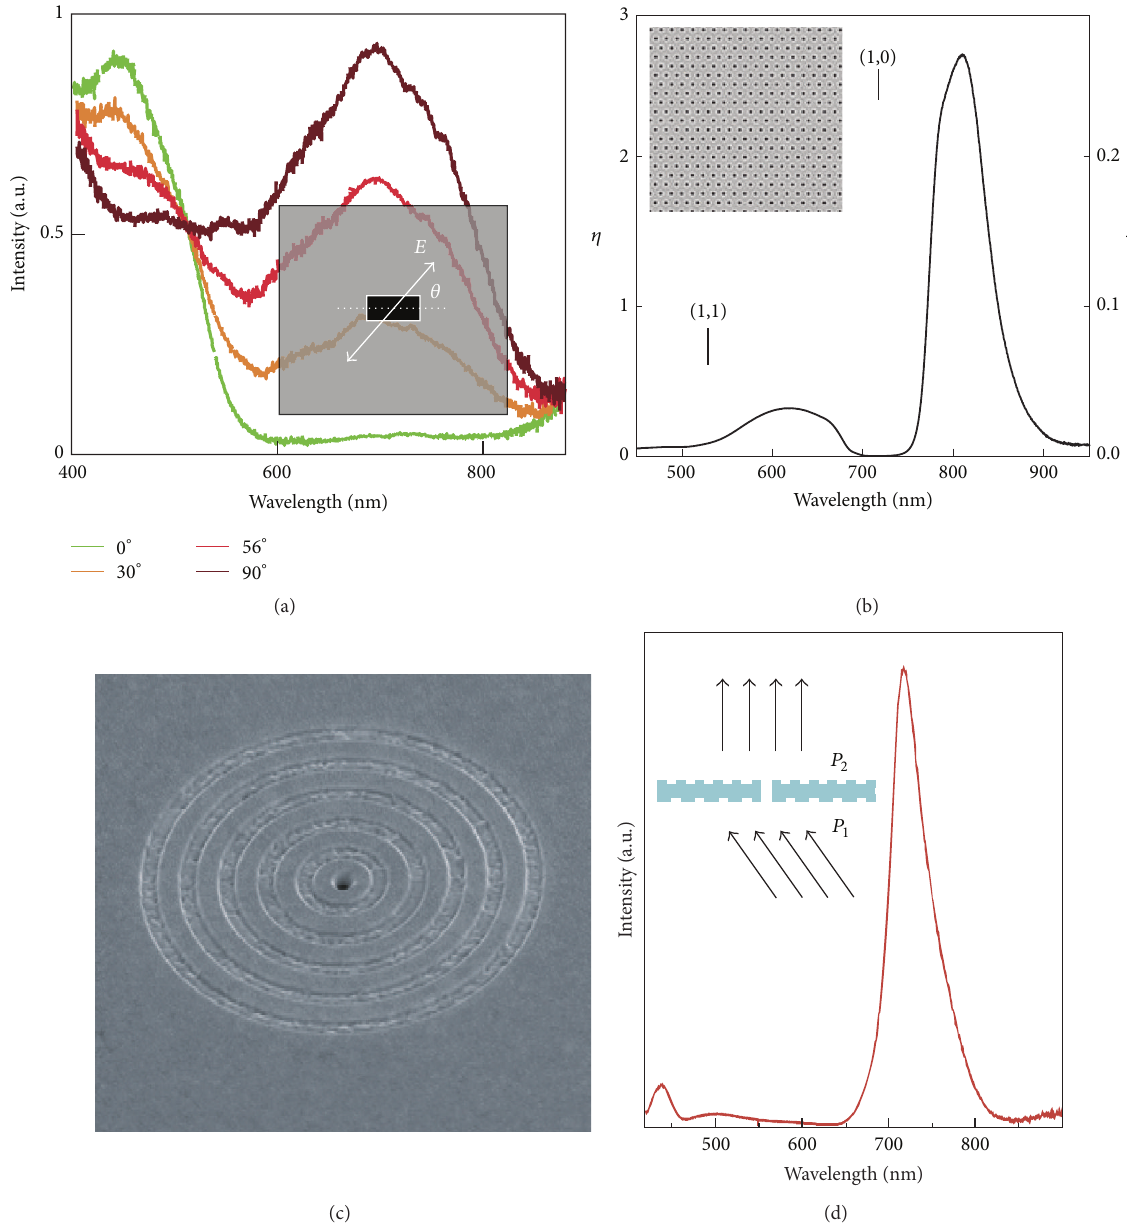
Figure 27: (a) Optical transmission properties of single rectangular hole in metal films. Inset shows the SEM image. (b) Transmission spectrum of hole arrays. The triangular hole array was milled in a 225 nm thick Au film on a glass substrate with an index matching liquid on the air side (hole diameter 170nm and period 520 nm). (c) SEM image of the bull’s eye structure. (d) Optical properties of the bull’s eye. Figures are reproduced from